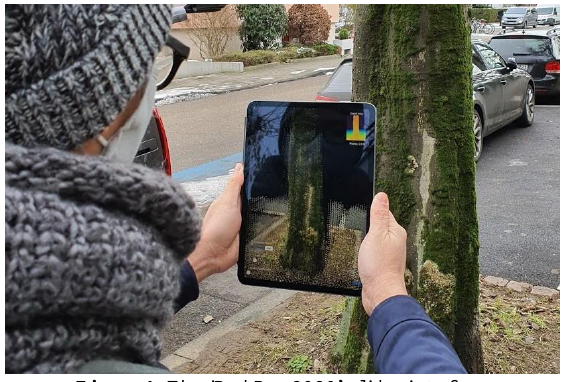
Figure 1 . The iPad Pro 2020’s lidar interface.